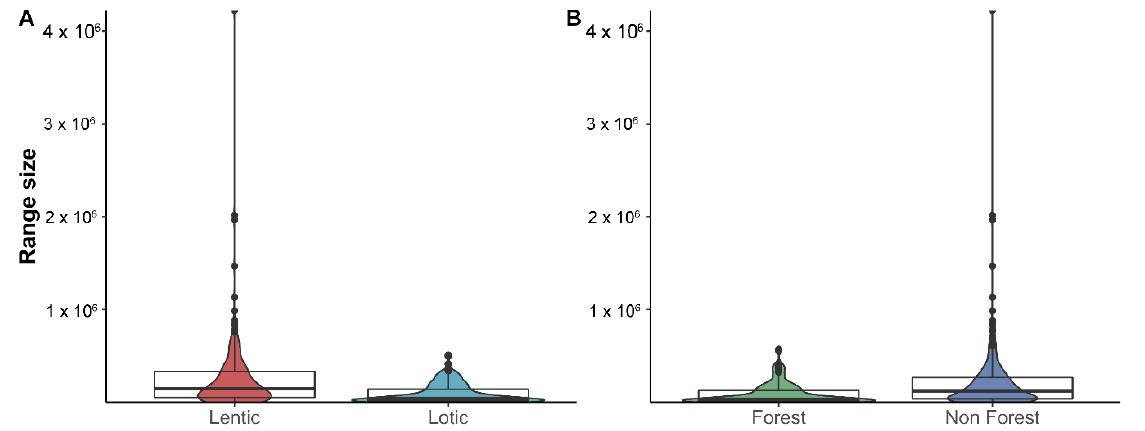
Figure 4. Range size (defined by the number of cells with predicted presence) for ( A ) lentic- and lotic-dependent Odonata species and ( B ) forest- and non-forest-dependent species.